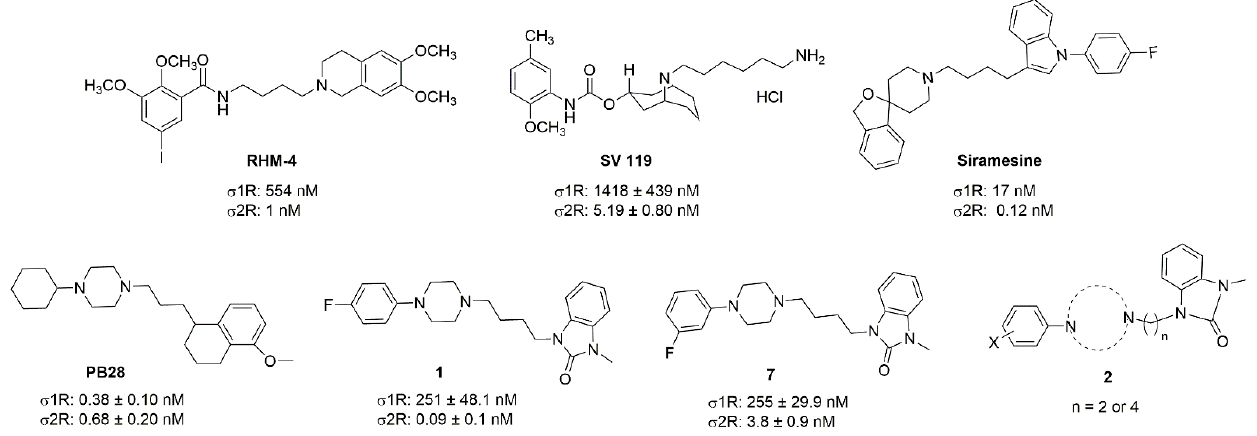
Figure 1. Structures of the σ 2R compounds described above.